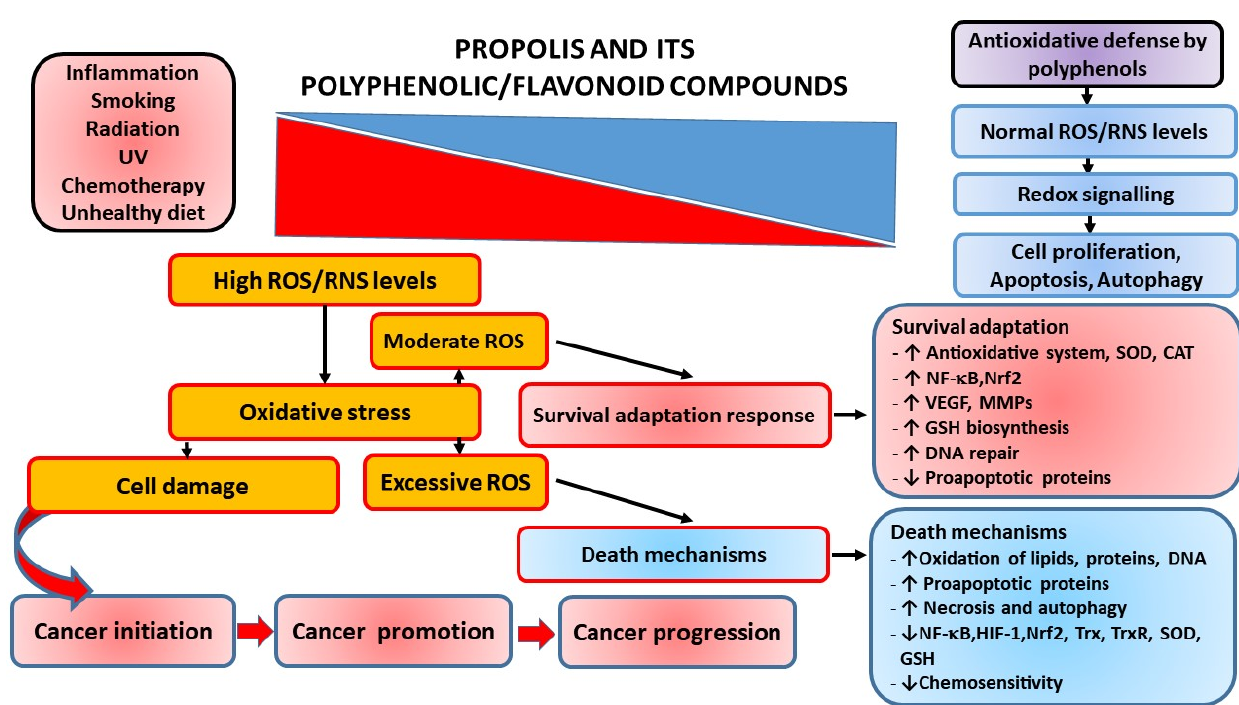
Figure 1. Interrelationship between ROS, oxidative stress, and inflammation-induced immune dysregulation and cancer pathophysiology. A number of factors induce the generation of high levels of reactive radicals (ROS), leading to oxidative stress (OS) and OS-induced inflammation. ROS can activate transcription factors NF- κ B, AP-1, and HIF-1 α that promote expression of pro-inflammatory genes, and activation of these redox-sensitive pathways may result in various cellular responses. ROS can serve as signaling molecules maintaining physiological functions such as cell growth, proliferation, and survival. Excessive production of ROS leads to oxidative damage of cellular macromolecules and cell death, while a moderate level of ROS leads to cell adaptation and survival through increased synthesis of antioxidant molecules, induction of angiogenesis factors, and increased DNA repair processes. In addition, ROS can stimulate signal transduction pathways and activate the key transcription factors such as Nrf2 and NF-kB. The altered patterns of gene expression induced by excess ROS contribute to the carcinogenesis process. Chronic inflammation upregulates cellular levels of inflammatory mediators, including COX-2, reactive oxygen and nitrogen species, and inflammatory cytokines, and activates protooncogenes. Depending on the overall functions and ratio of inflammatory mediators, the inflammatory response may be pro- or anti-tumorigenic. Finally, the antioxidant regulatory mechanisms that modulate and balance host defense, inflammation, and OS are indicated. In general, the strategies of antioxidant and anti-inflammation therapy as a defensive approach against cancer include: (1) use of antioxidants, (2) suppression of inflammation, and (3) stimulation of repair processes. Note: ROS, Reactive oxygen species; NO, Nitric oxide; NF- κ B, Nuclear factor kappa-light-chain-enhancer of activated B cells; UV, ultraviolet radiation; SOD, Superoxide dismutase; CAT, Catalase; Nrf2, nuclear factor E2-related factor 2; VEGF, Vascular endothelial growth factor; MMPs, Matrix metalloproteinases; GSH, Reduced glutathione; HIF-1, Hypoxia-inducible factor-1; Trx, Thioredoxin; TrxR, thioredoxin reductase.